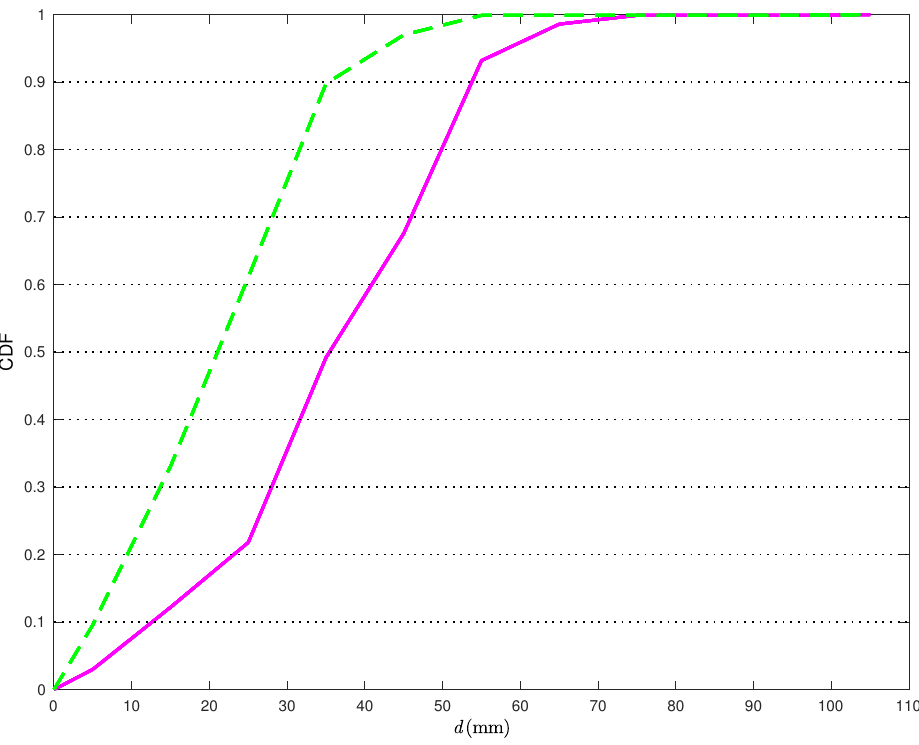
Figure 9. CDFs of the distance errors obtained with the TSML localization algorithm in Figure 8 without (solid line) and with (dashed line) the statistical